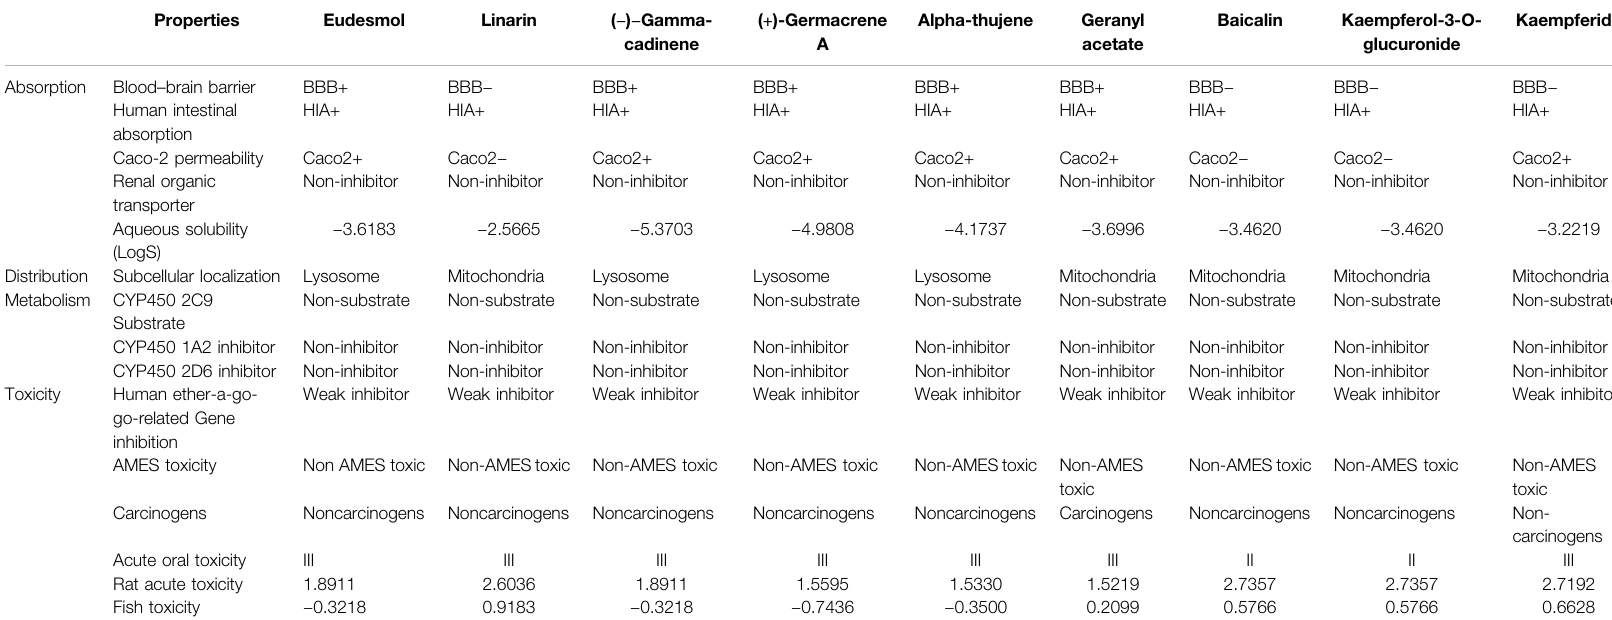
TABLE 2 | Pharmacodynamic pro fi le of top three hit phytochemicals from each of the three selected plants ( Mentha arvensis , Coriandrum sativum , and Ocimum tenui fl orum ).